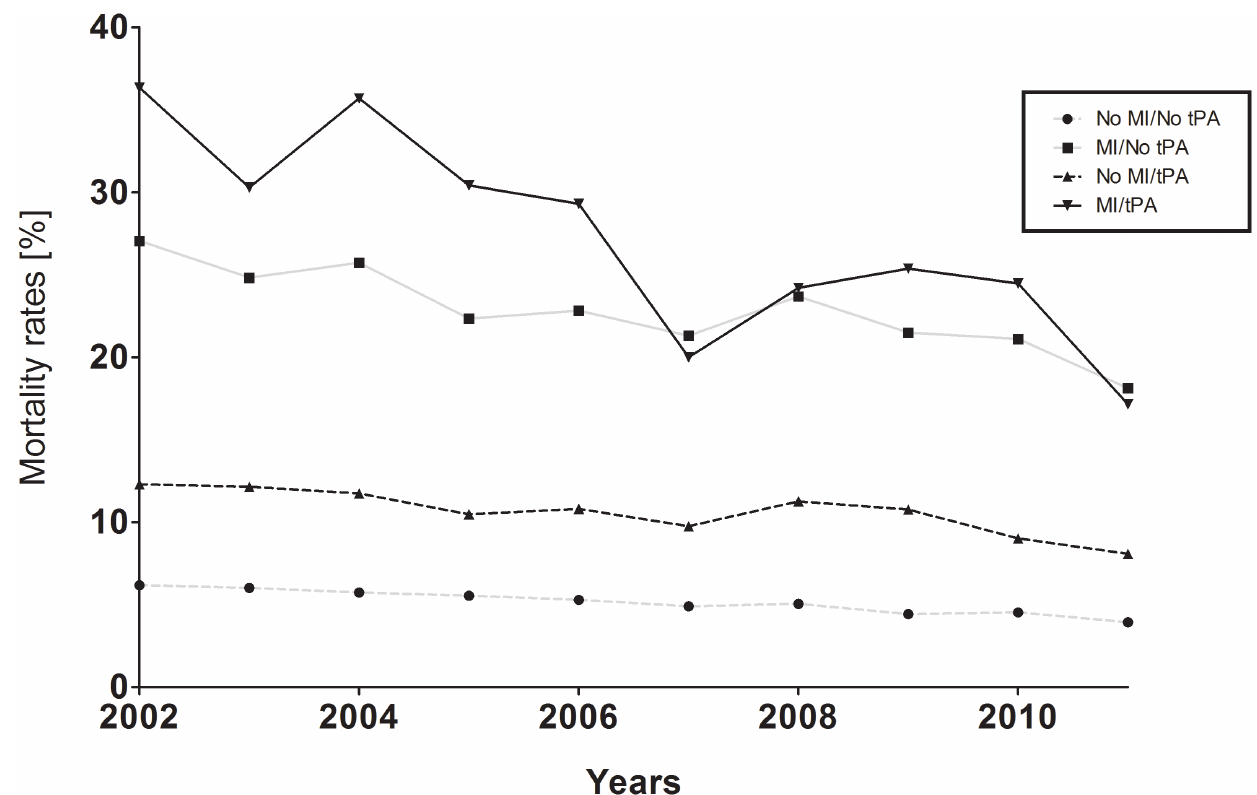
Figure 1. Annual mortality: Inpatients admitted with ACI.